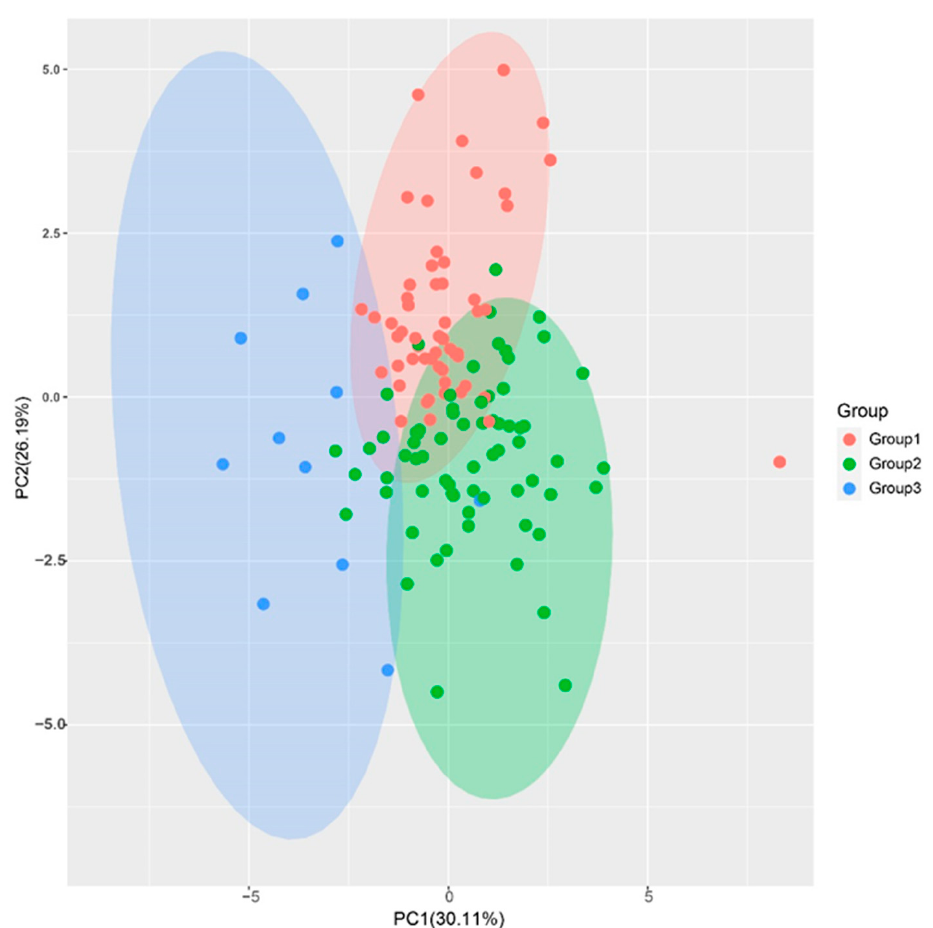
Figure 3. Principal component analysis of the sugarcane hybrid F 1 population. The plot was drawn using the first two PCs of the F 1 population. The red, green, and blue dots indicate the F 1 progenies clustered in Group I, Group II, and Group III, respectively. Table 3. Principal component values of 24 F 1